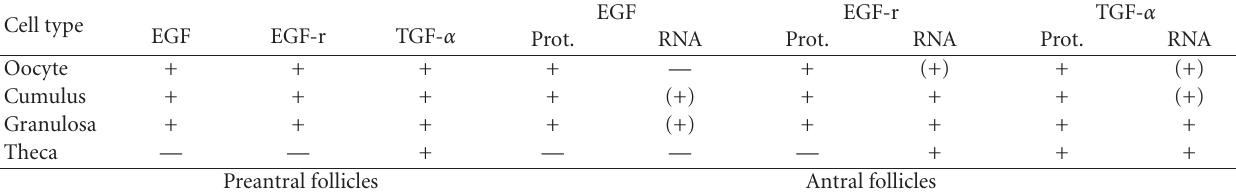
EGF: epidermal growth factor, EGF-r: EGF receptor; TGF- α : transforming growth factor alpha, +: yes; —: no; Prot.: